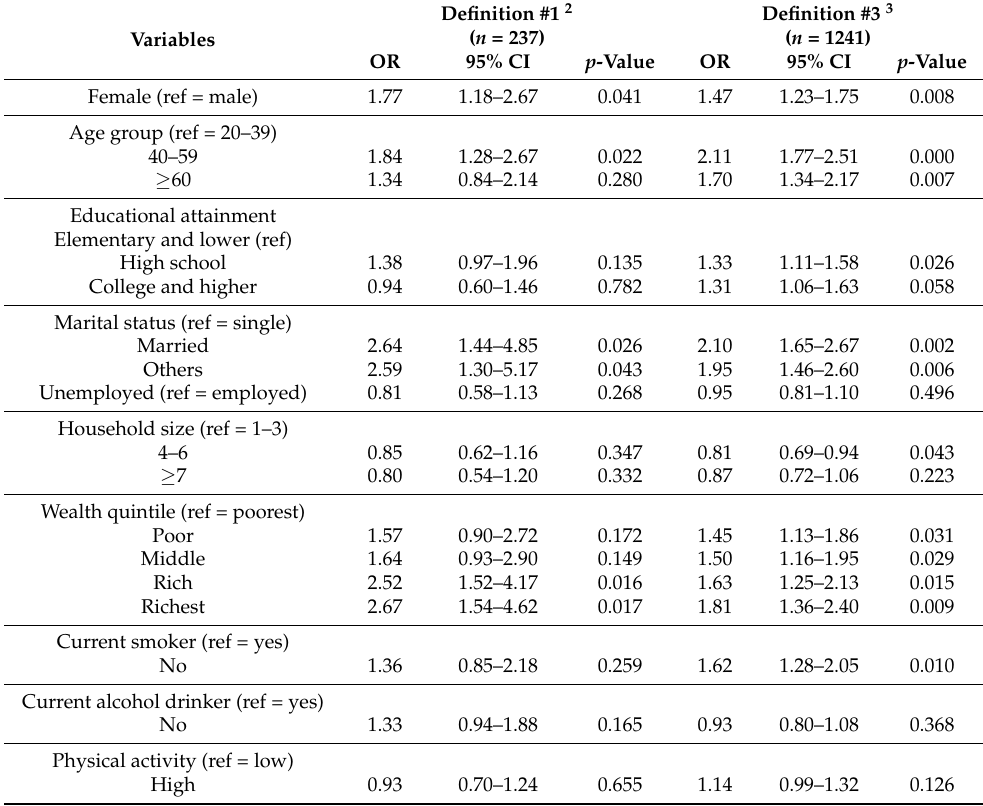
Table 4. Logistic regression of factors associated with DBM in adults in the Philippines by two definitions 1